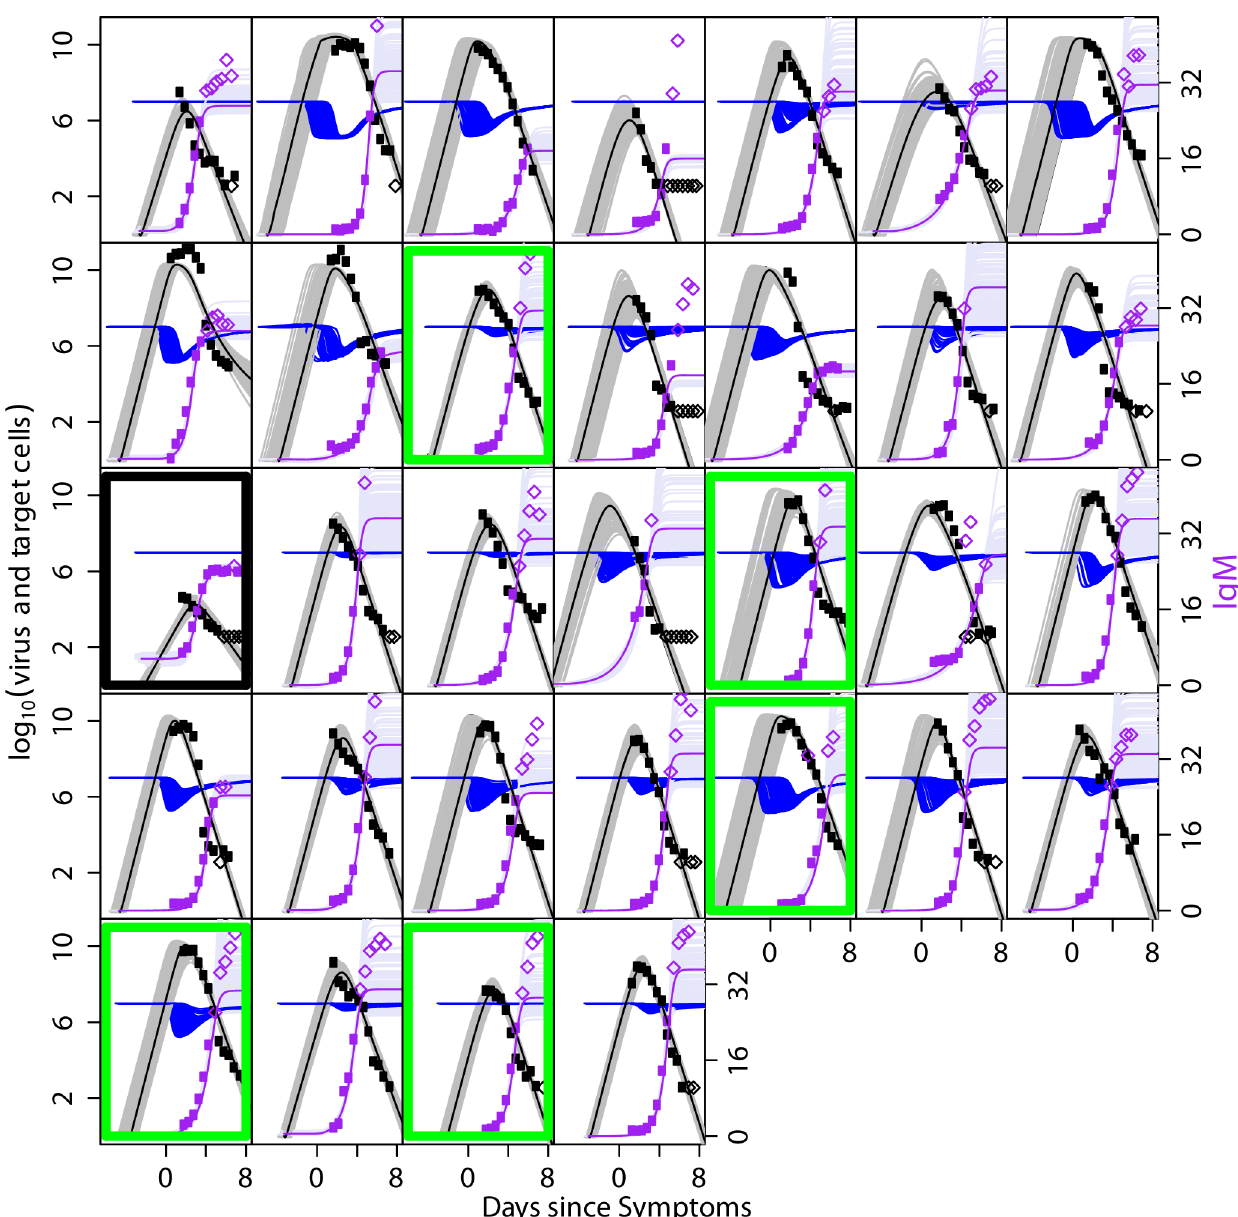
Fig 3. Fit of the model to virus and IgM measurements for DENV1-infected subjects for the model variant in which antibody removed virus. Each plot shows an individual patient. Virus data is shown in black and IgM data in purple. Parameters z 0 , η 1 , η 2 , IP and SF fitted as patient specific, other parameters fitted per group. Mauve, grey and blue curves show 100 samples from the posterior distributions of antibody, virus and target cell trajectories, respectively. Median fits are shown as bold lines (purple shows IgM, black shows virus). Parameter estimates are shown in Table 2. Subjects classified as primary infections highlighted with green